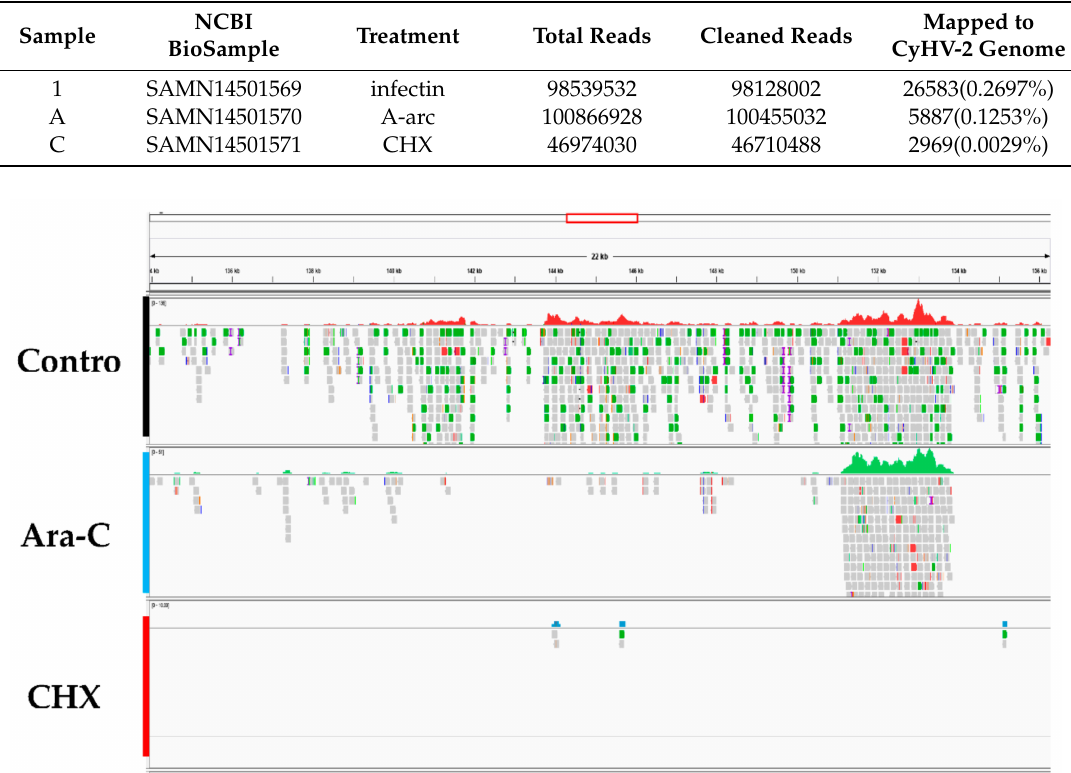
Figure 6. High-throughput sequencing data analysis. Panels show the differences in transcript expression levels among the groups after treatment with different inhibitors. Control: Infected CyHV-2 group; Ara-C: Infected with CyHV-2 and treated with cytarabine; CHX: Infected with CyHV-2 and treated with